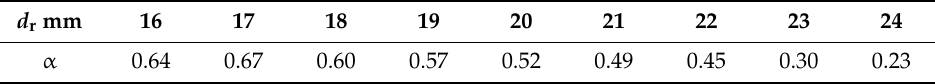
Table 4. Comparison of α under different d r.